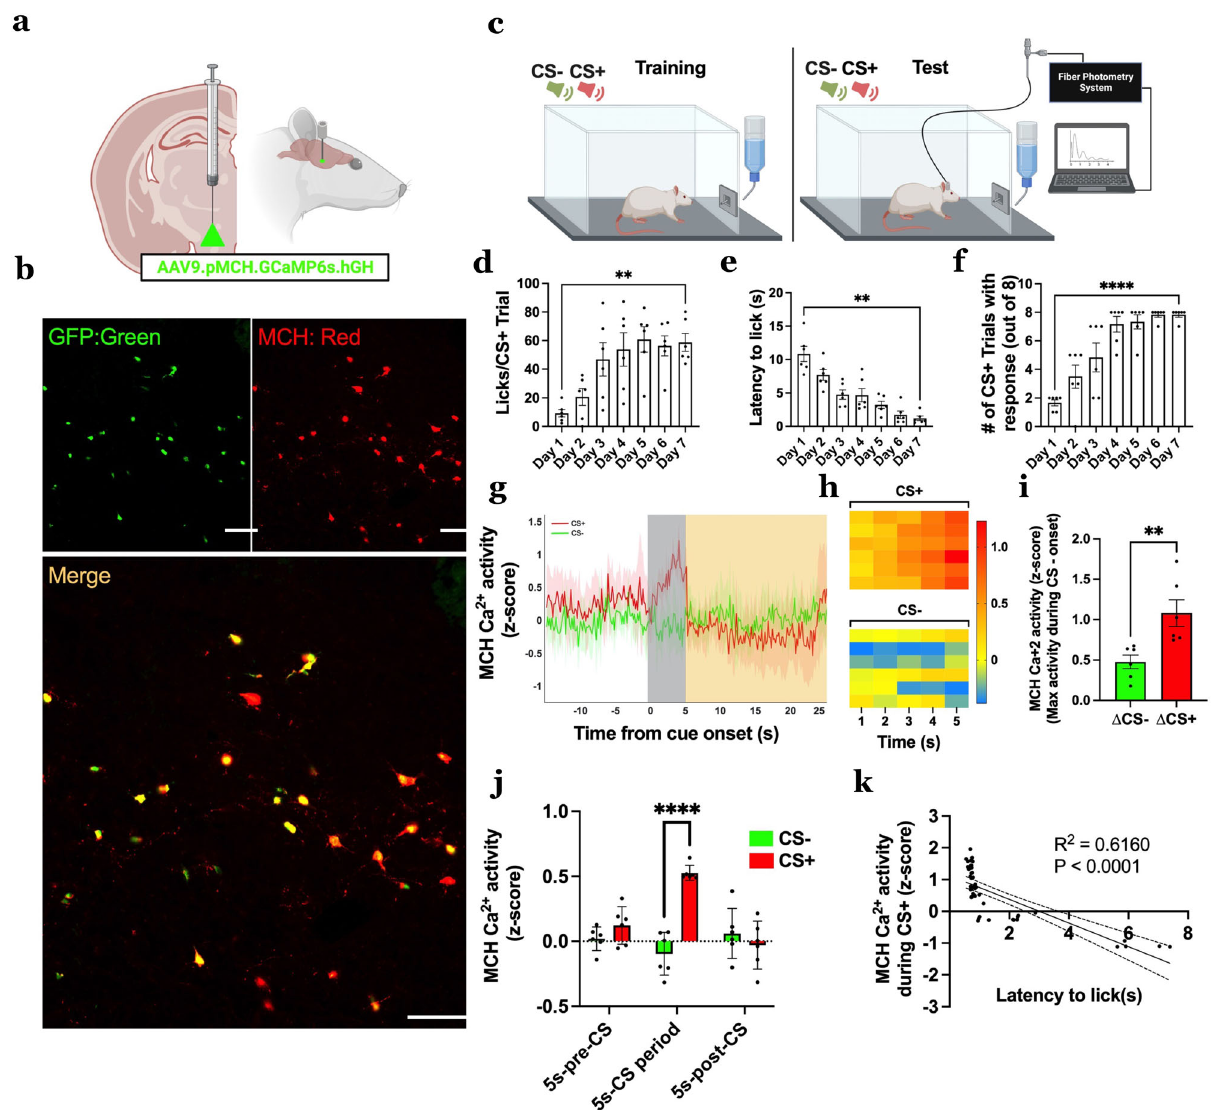
Fig.1|PhysiologicalMCHneuronCa 2+ activityincreasesinresponsetodiscrete food-predictivecuesandisassociatedwithbehavioralappetitiveresponsivity. a Schematic diagram depicting a viral approach to record physiological